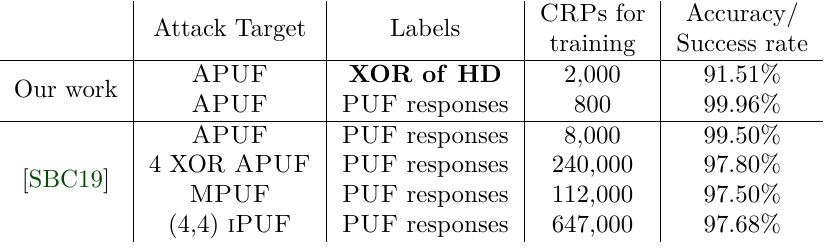
Table 1: Comparison of our results to selected results presented in [SBC19]. The results for learning through HD refer to an attack using HD generated for a (7,1,7) repetition code. For learning through HD the mean PUF success rate is provided. The challenge size is always 128